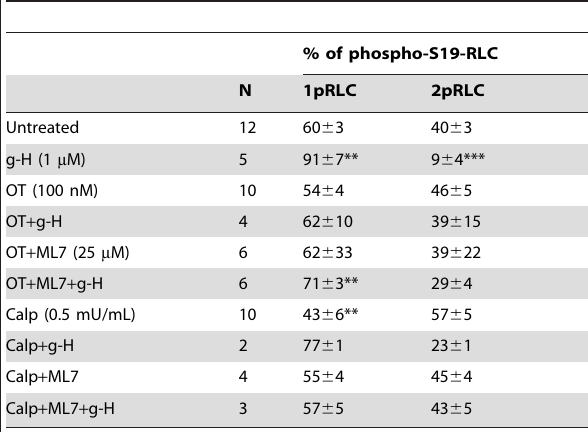
Table 2. Changes in Relative Proportions of Phospho-S19- RLC Isotypes in uterine